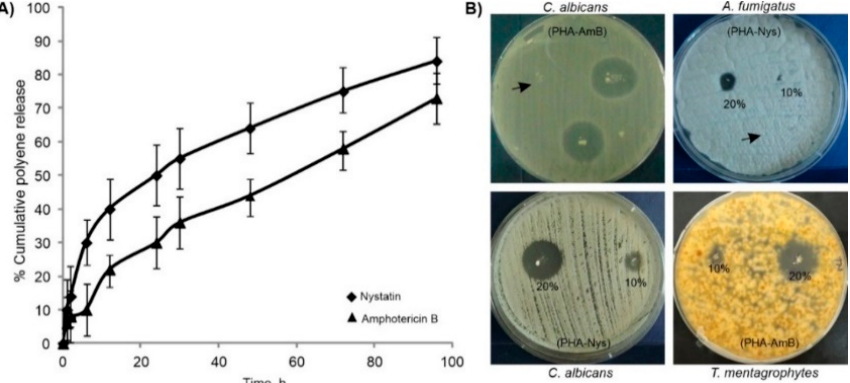
Figure 2. Cumulative release profiles of polyenes from PHA/polyene microspheres in phosphate buffer ( A ) and in vitro antifungal activity of dry PHA/polyene microspheres on agar plates ( B ). Representative plates showing inhibition zones of growth of the tested fungal pathogens around microspheres are shown. Arrow marks PHA microspheres without